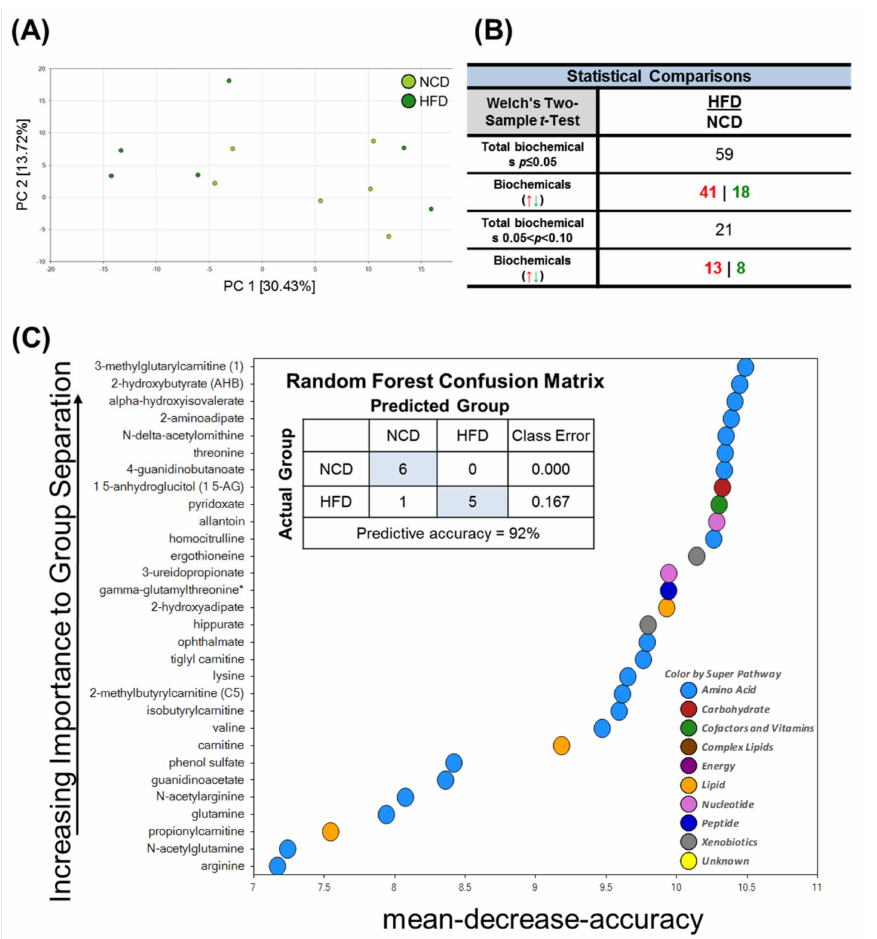
Figure 3. Principal component analysis (PCA), Welch’s two-sample t -Test, random forest (RF) of metabolites in the brain in mice fed NCD and HFD. PC is the principal component that distinguishes the NCD group and the HFD group. ( A ) PC1 is the first principal component; PC2 is the second principal component; PC1 explained 30.43% of the variation; PC2 explained 13.72% of the variation. ( B ) Metabolic changes statistical comparisons through Welch’s two-sample t -Test between the NCD group and HFD group. 59 statistically significant metabolites ( p ≤ 0.05) out of 407 were identified